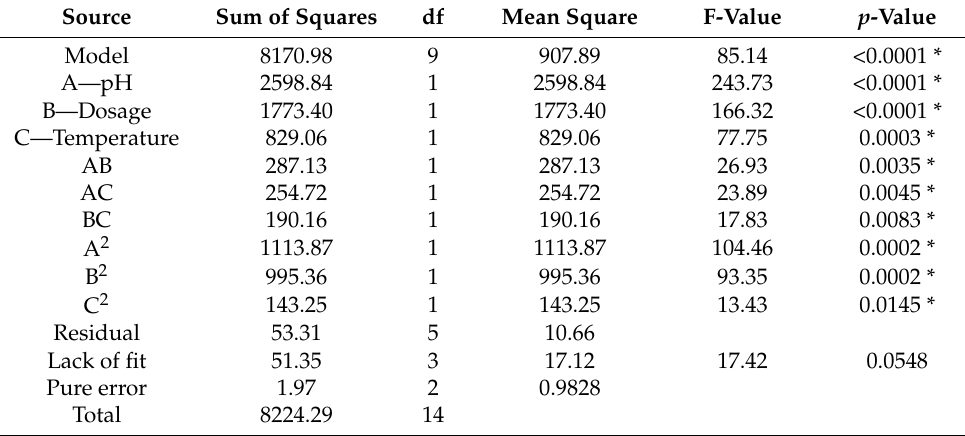
Table 4. ANOVA for quadratic model composed for dye adsorption from textile wastewater by orange seed powder as